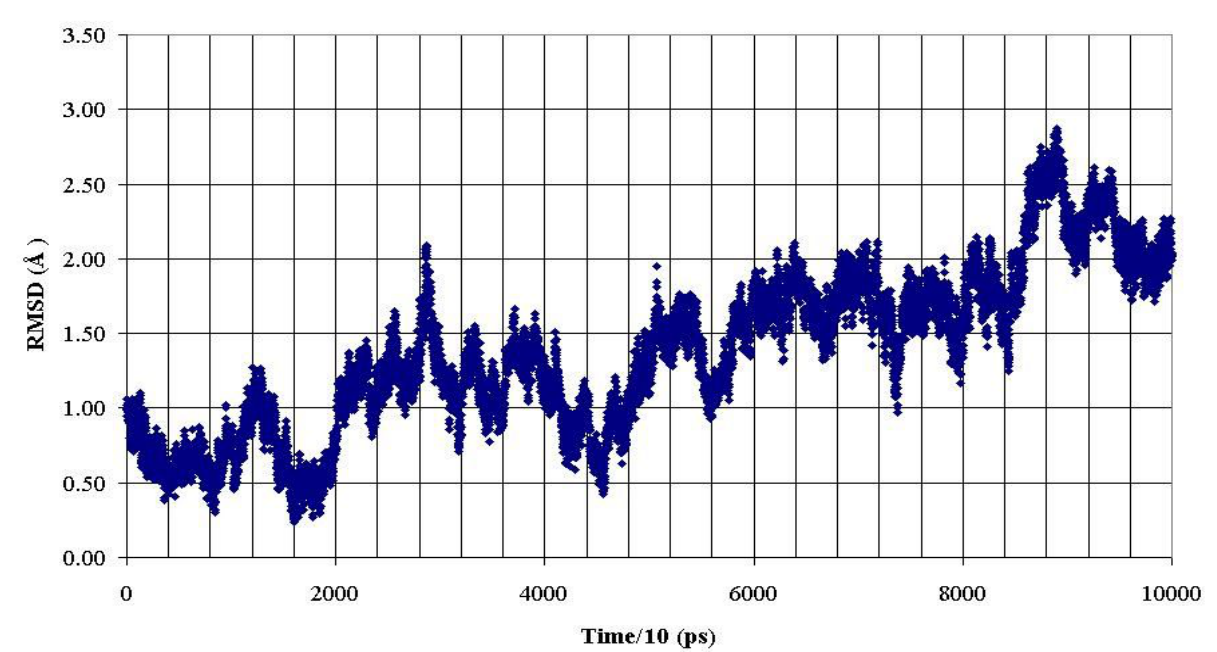
Figure 6. RMSD of backbone heavy atoms of the PDTRP fragment of the nonglycosylated peptide AHG21 during 1 ns MD simulation within reference at the crystal structure [11].